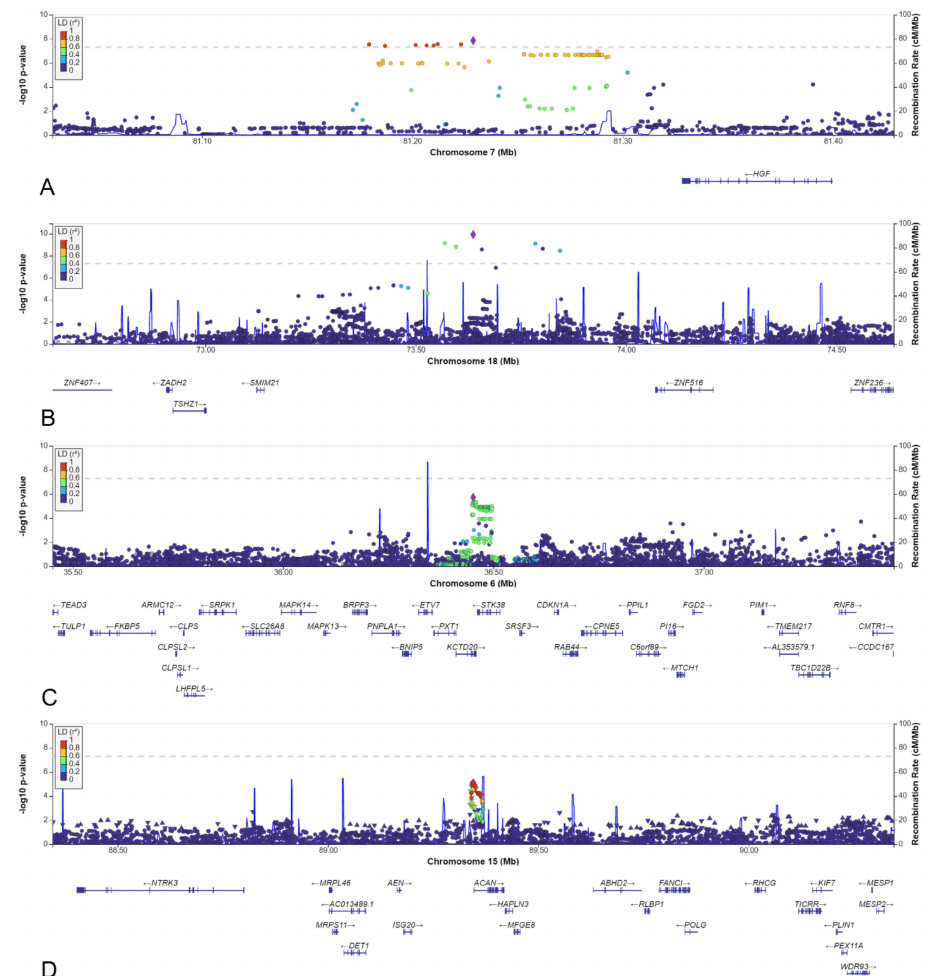
Figure 6. LocusZoom plots of: ( A ) SNV rs140804918 on chromosome 7. ( B ) SNV rs184382636 on chromosome 18. ( C ) SNV rs148413365 on chromosome 6. ( D ) SNV rs111283115 on chromosome